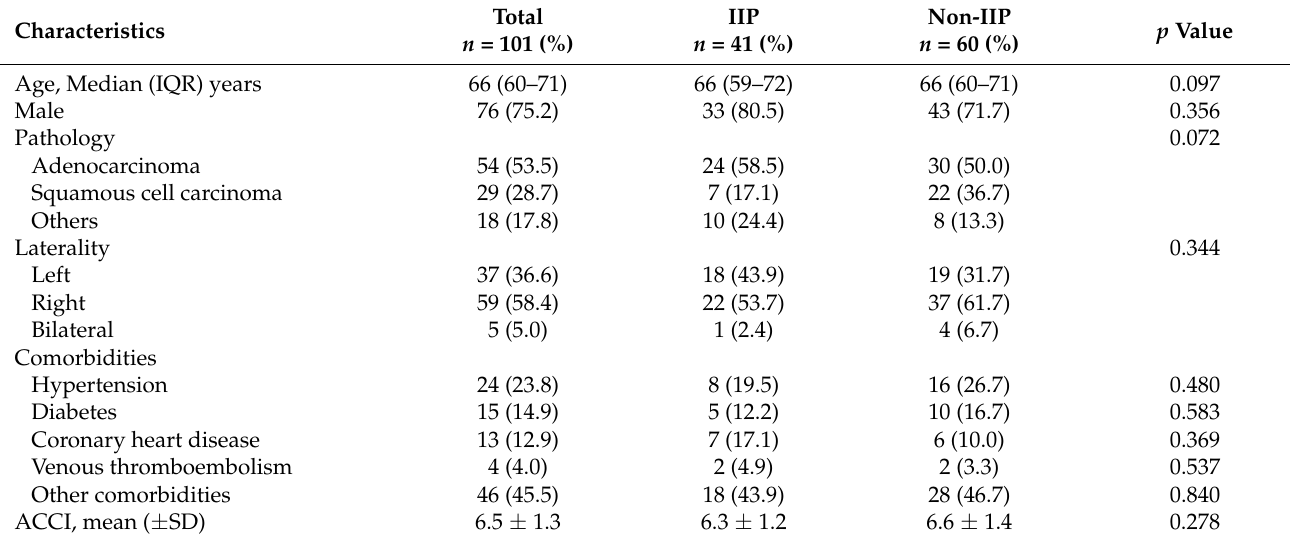
Table 8. Characteristics of patients with lung cancer in IIP and non-IIP